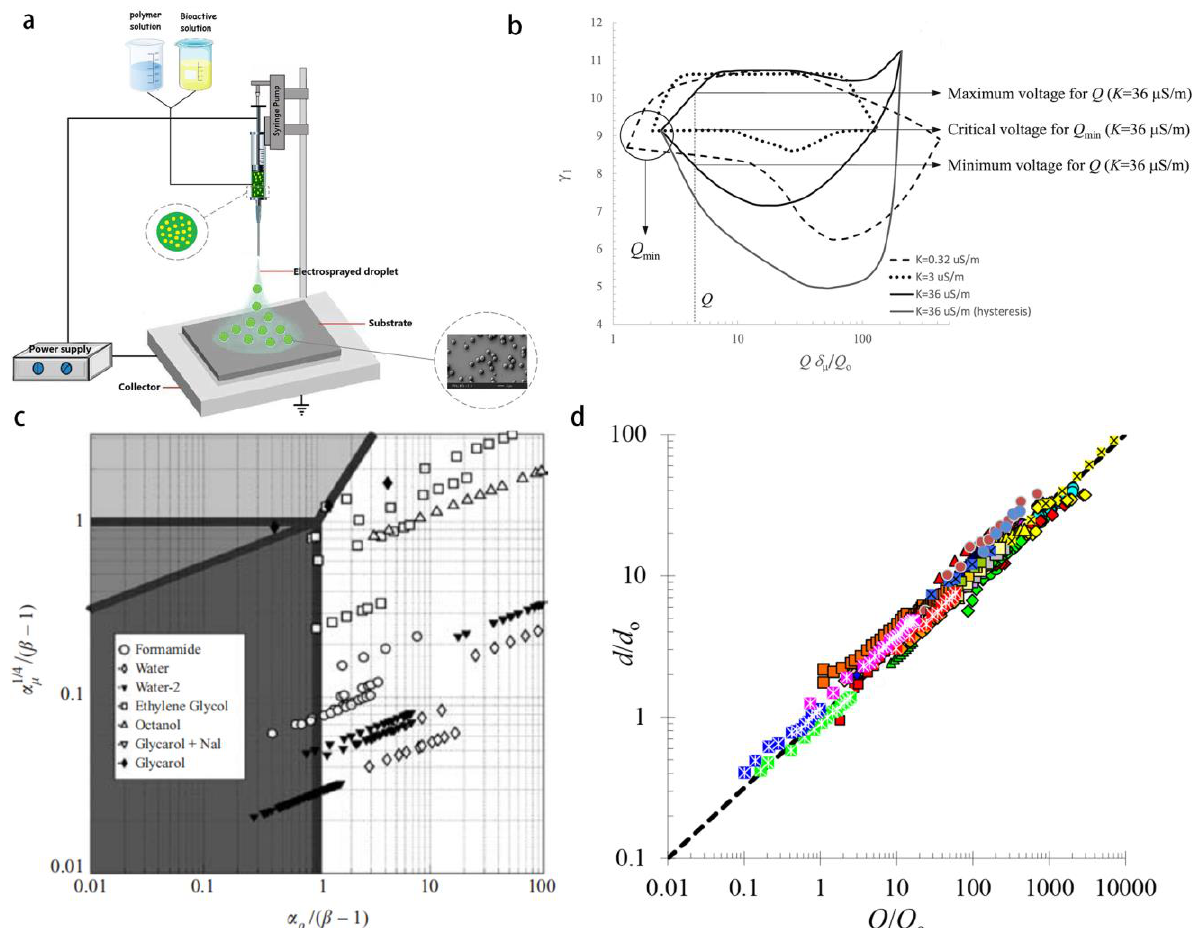
Figure 4. ( a ) Setup of electrospray, a potential difference is applied between the disperse phase in the feeding capillary and the grounded plate downstream, reproduced from [50], copyright 2021, Elsevier. ( b ) The operational conditions of electrospray for having steady cone-jet mode, in plane of Taylor number and normalized flow rate of disperse fluid, reproduced from [52], copyright 2018, Elsevier. ( c ) Phase diagram of 4 main regimes with dominant forces for electrospray, including the inertia-electric mode (white), inertia-polarization mode (dark grey), viscous-electric mode (light grey), and viscous-polarization mode (medium grey). Most of the experiments step into the inertial-electric (IE) mode. Reproduced from [56], copyright 2004, Cambridge University Press. ( d ) Normalized droplets diameter vs. the normalized flow rate. Here Q o = σε 0 / ρ K , d o = the surface tension, ε 0 the permittivity of vacuum, and ρ and K the fluid density and conductivity, respectively. The power law scaling is consistent with Equation (2), and with the experiments using different fluids represented by different colors. Reproduced from [52], copyright 2018, Elsevier